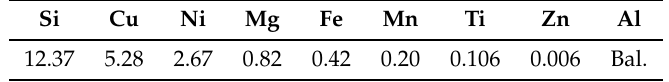
Table 1. Chemical composition of analyzed Al–12Si–CuNiMg matrix alloy (in wt.%).